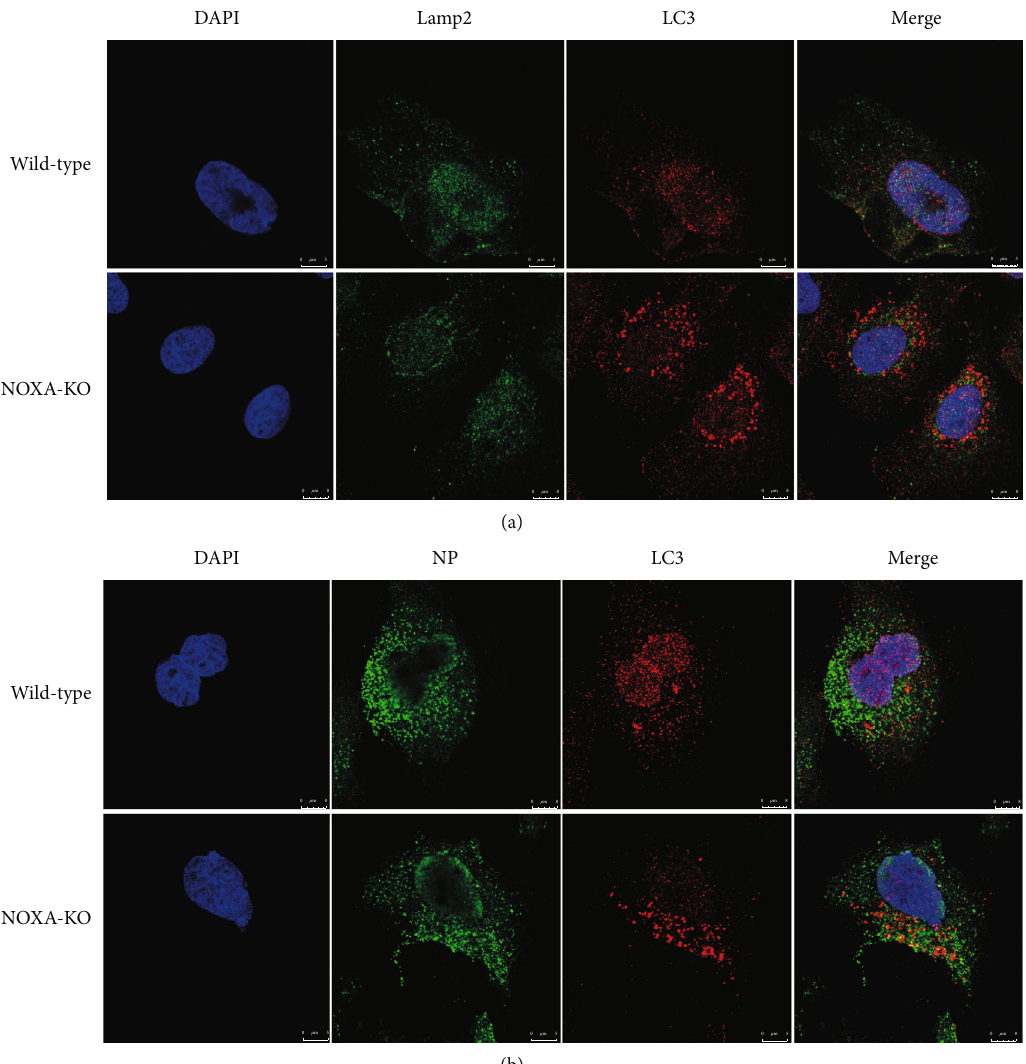
Figure 4: Noxa-de fi cient results in the autophagic degradation of in fl uenza virus particles. (a) Wild-type and Noxa-de fi cient A549 cells were infected with the A/WSN/33 (H1N1) virus for 8h. Representative images of immuno fl uorescence staining in cells with antibodies against Lamp2 (green) and LC3 (red). Blue: positive staining of DAPI. Scale bars, 10 μ m. (b) Wild-type and Noxa-de fi cient A549 cells were infected with the A/WSN/33 (H1N1) virus for 8h. Representative images of immuno fl uorescence staining in cells with antibodies against NP (green) and LC3 (red). Blue: positive staining of DAPI. Scale bars, 10 μ